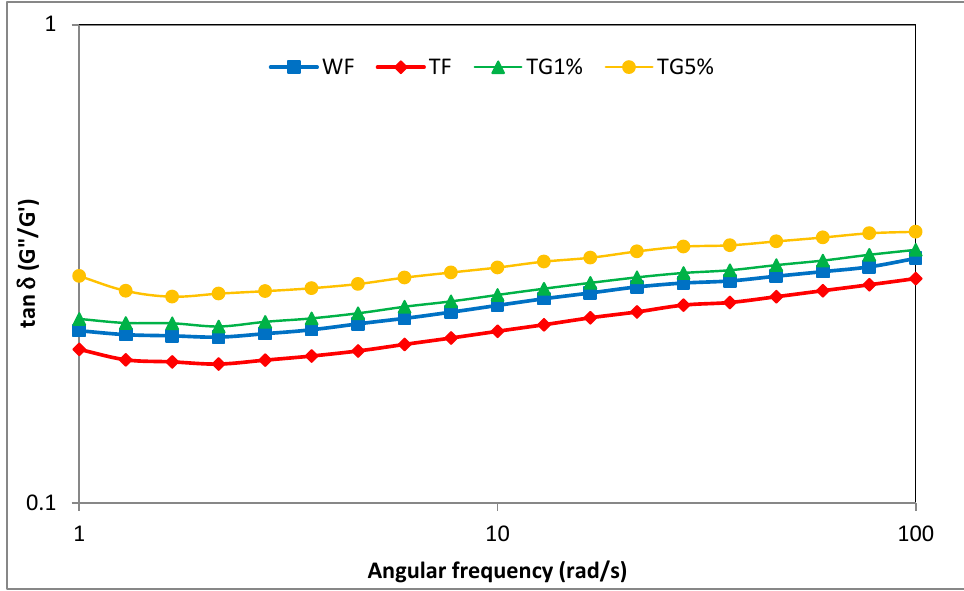
Figure 6. Tangent δ depending on the angular stress of the analysis of wheat flour, triticale flour and system of triticale fl our with vital gluten. Table 5. Parameters of power law equations describing viscoelastic properties (25 °C) of systems wheat fl our, triticale fl our and triticale fl our with vital gluten.